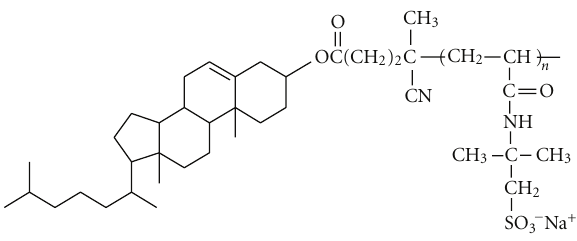
Figure 8: Chemical structure of cholesterol-end-capped polyelectrolyte.